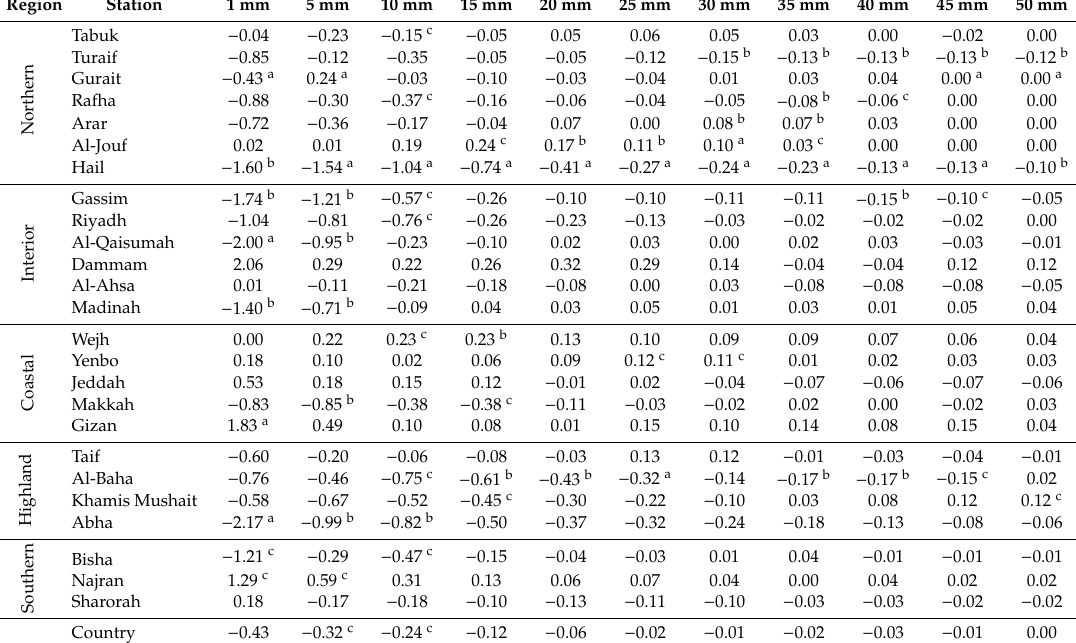
Table 2. Rainfall trends (mm decade − 1 ) at di ff erent station locations in Saudi Arabia. The superscripts a, b, and c represents trend significance at the 90%, 95%, and 99% confidence level,